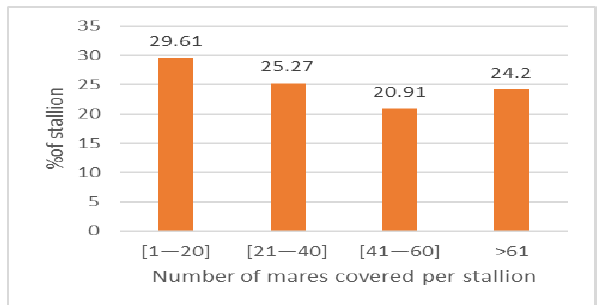
Figure 4. The number of mares covered per stallion.